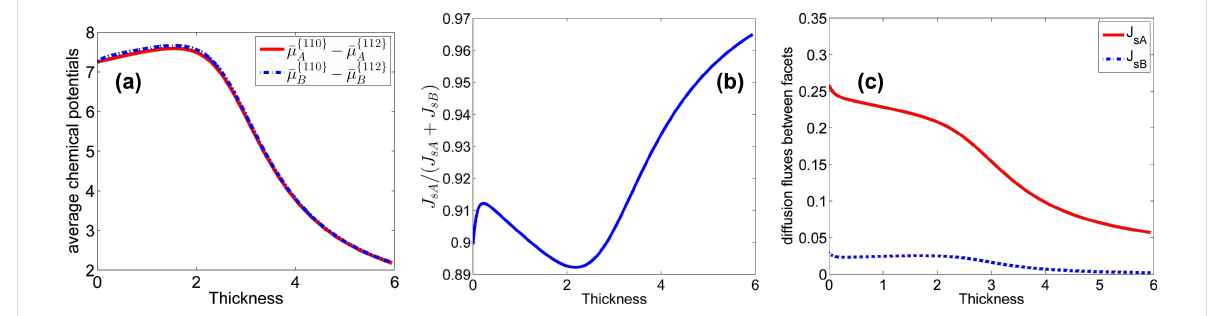
Figure 8: (a) Evolution of the difference of the average chemical potentials of the facets with the thickness of the shell(× 2.5 nm). (b) Evolution of the portion of Al atoms taken in the diffusion flux along the surface. (c) Evolution of the diffusion fluxes of Al atoms (denoted by A) and Ga atoms (denoted by B) from {110} facets to {112}